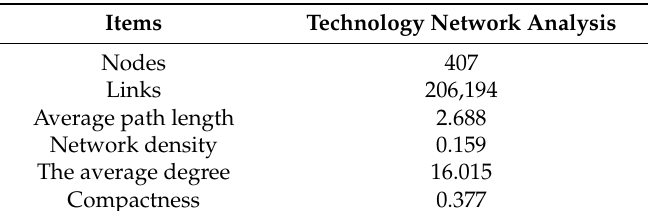
Table 4. Parameters related to technology network analysis.